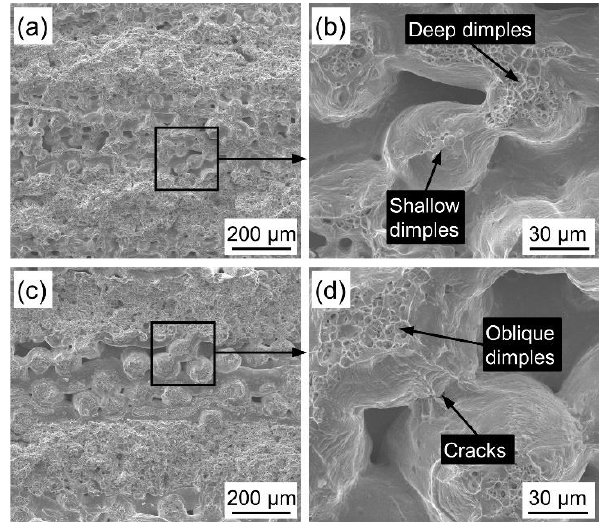
Figure 8. Impact fractures morphology of PWMCPPs with different wire mesh diameters. ( a ) Lower magnification and ( b ) higher magnification of the PWMCPP with 50 μm wire mesh diameter; ( c ) lower magnification and ( d ) higher magnification of the PWMCPP with 100 μm wire mesh diameter.